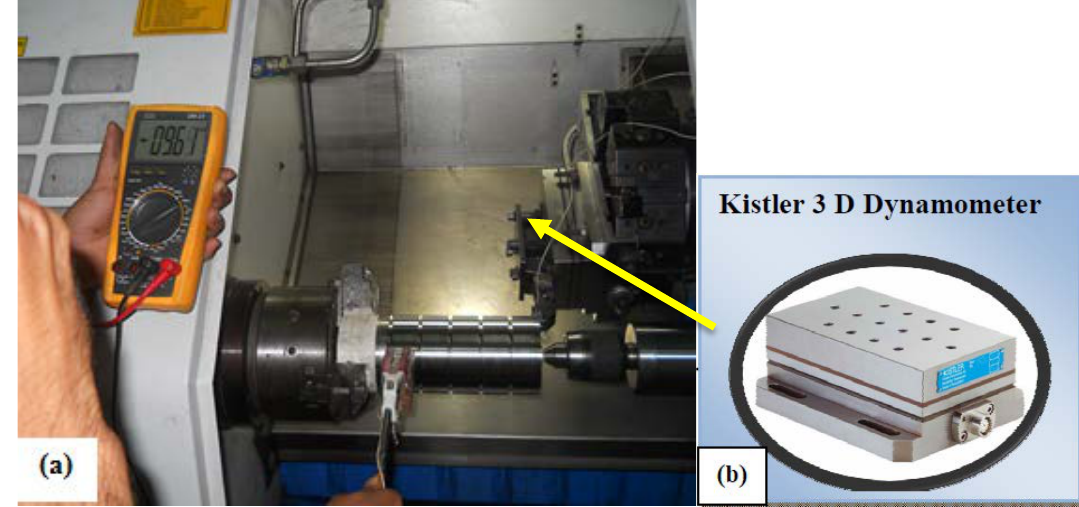
Fig. 1. (a) Photographic view of Kistler 3-D Dynamometer during turning; (b) Kistler 3-D Dynamometer unit